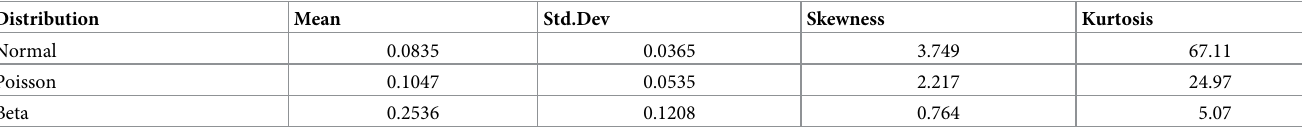
Table 6. Statistics of Jeffreys divergence information penalty for all demographic